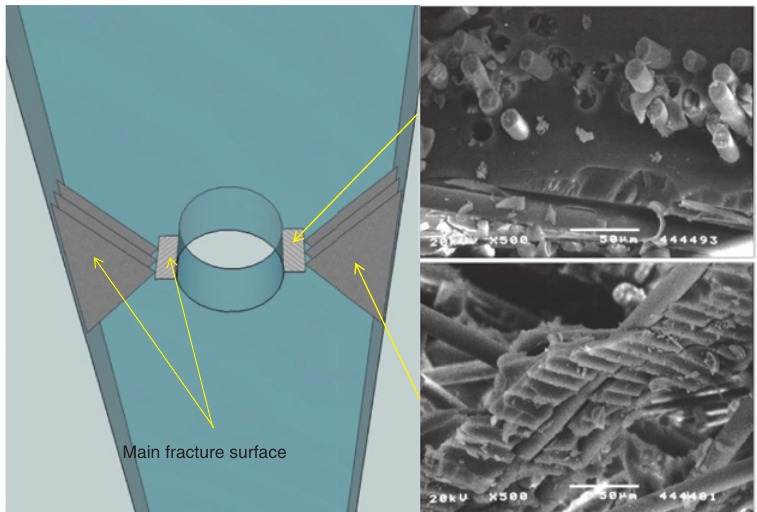
Figure 9 Fracture characteristics of notched specimen in parallel area and fan shape